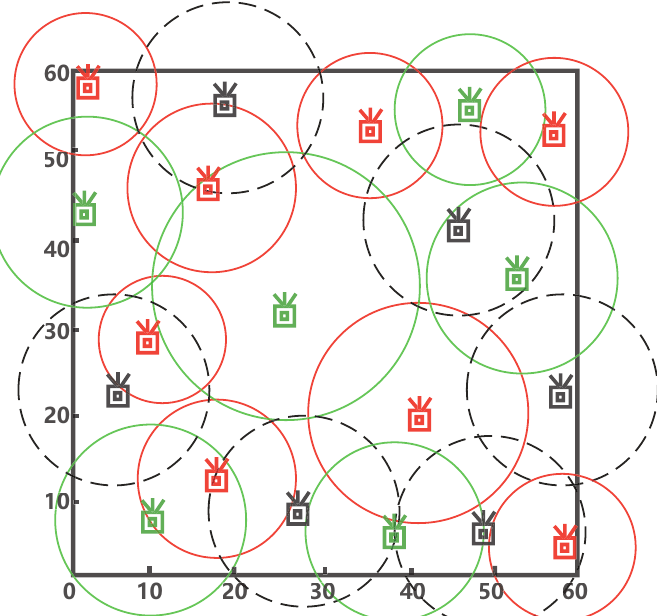
Figure 4. An example of reader